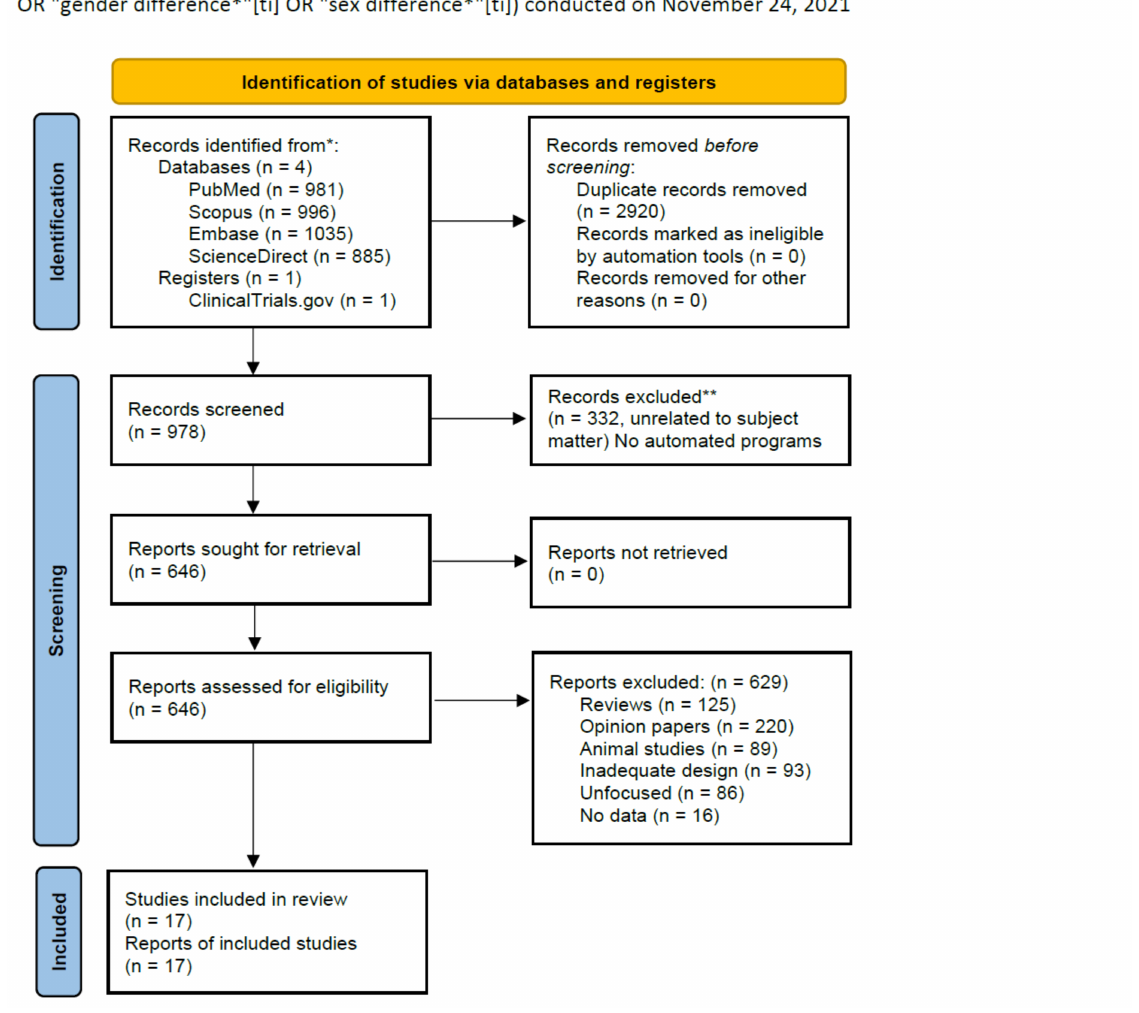
Figure 1. PRISMA Flow diagram of literature search, (http://www.prisma-statement.org/, accessed on 31st July 2021). * Consider, if feasible to do so, reporting the number of records identified from each database or register searched (rather than the total number across all databases/registers). ** If automation tools were used, indicate how many records were excluded by a human and how many were excluded by automation tools. From: Page MJ, McKenzie JE, Bossuyt PM, Boutron I, Hoffmann TC, Mulrow, CD, et al. The PRISMA 2020 statement: an updated guideline for reporting systematic reviews. BMJ 2021;372:Nn71. doi: